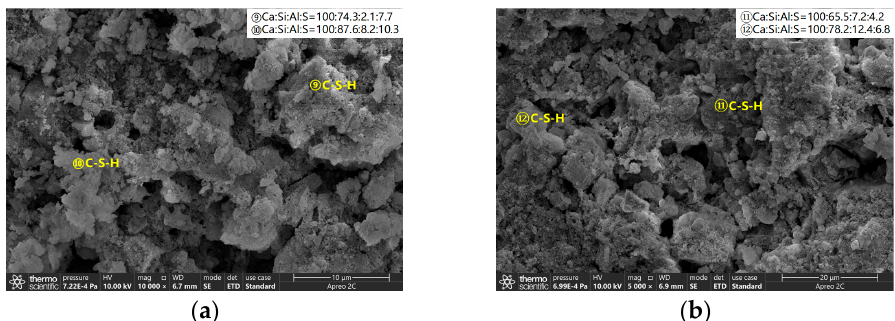
Figure 11. The microstructure of leached cement samples: ( a ) PA0-045-leached; ( b ) PA9-045-leached.